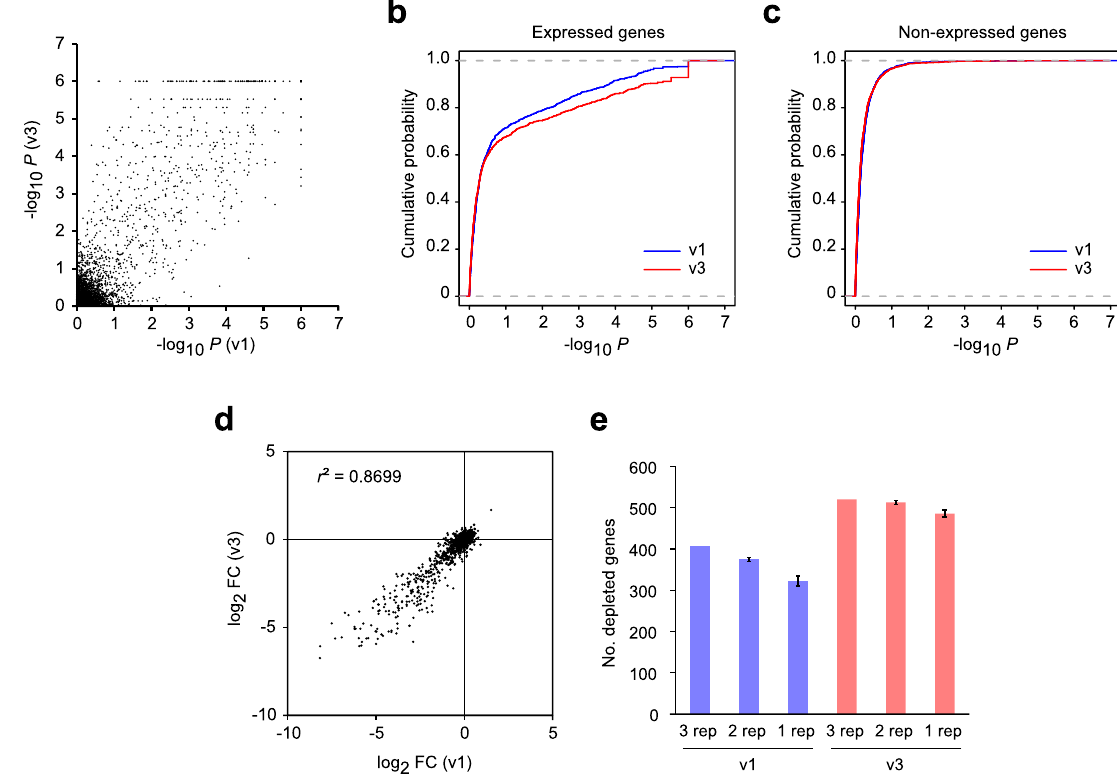
Figure 5. Screening performance of the 5-gRNAs-per-gene Human v1 and 6-gRNAs-per-gene Human v3 libraries and the effect of replicates. ( a ) Scatter plot comparing gene-level significance between the Human v1 and v3 libraries. ( b , c ) Cumulative distribution function of gene-level significance of expressed ( b ) and non- expressed ( c ) genes. Non-expressed genes are defined as having FPKM values of less than 0.5 and expressed genes as having FPKM values of 0.5 and above. ( d ) Scatter plot comparing the fold change between the Human v1 and v3 libraries. ( e ) The number of depleted genes detected by the Human v1 and v3 libraries with different number of